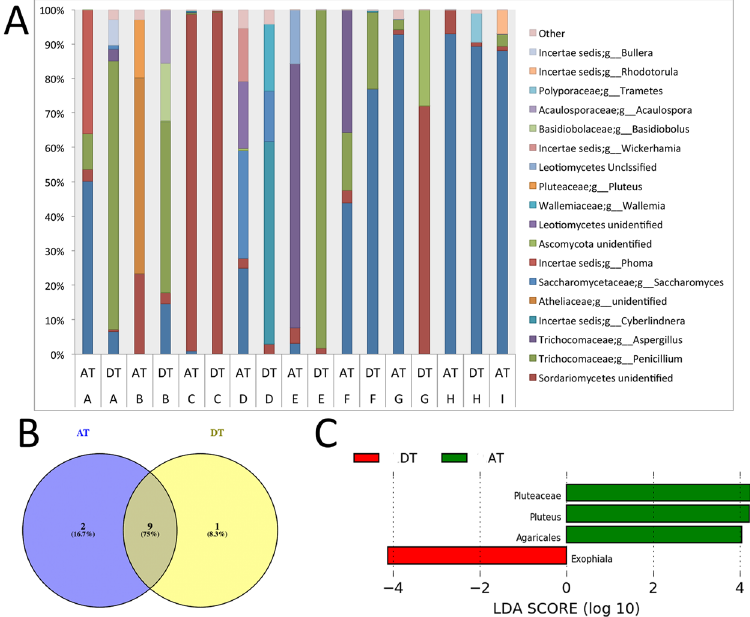
Figure 4. Alpha and beta diversity analysis of fungal communities associated with chronically diseased tissue and adjacent tissue. (A ) Fungal community composition profiles illustrate abundances of prevalent taxonomic orders and families. All taxa unassigned at the kingdom level were removed. Patients are arbitrarily labelled A-I with chronically diseased tissue (DT) and adjacent tissue (AT) indicated. ( B ) Venn diagram of core mycobiome (including OTUs found in ≥ 80% of the samples) displays the number of OTUs that are similar (75.0%) and unique between chronically diseased tissue (DT) (8.3%) and adjacent tissue (AT) (16.7%). (C) LDA Effect Size (LEfSe) enrichment plots reveal significantly enriched fungi identified within each tissue type (chronically diseased tissue (DT) and adjacent tissue (AT)). Taxa with an LDA score > 1.5 are presented.